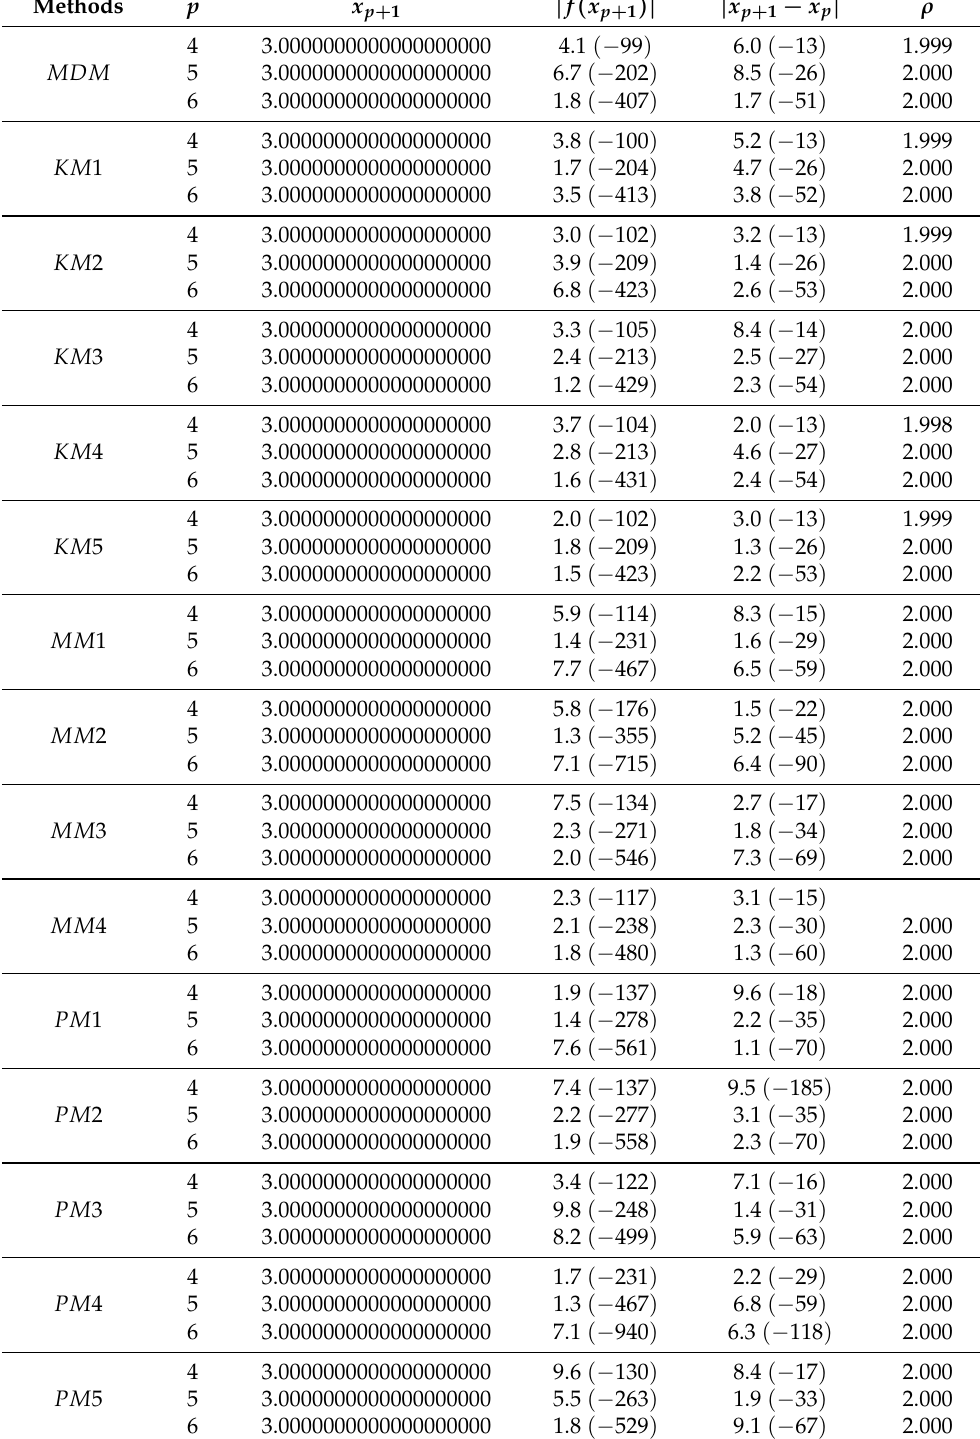
Table 3. Comparison of different iterative methods on Example